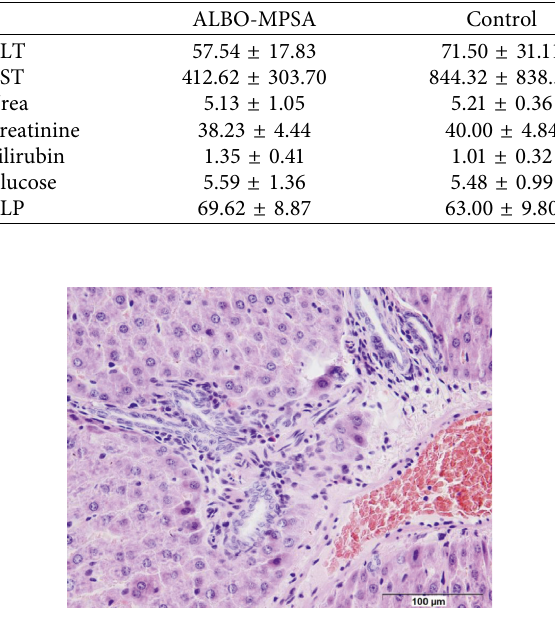
Figure 2: A normal-sized portal tract with a slight inflammatory infiltrate with eosinophils included (HE,